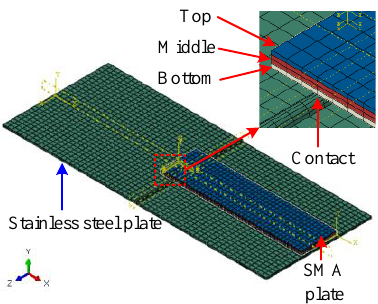
Figure 16. Semi-symmetric model of the active morphing skin.